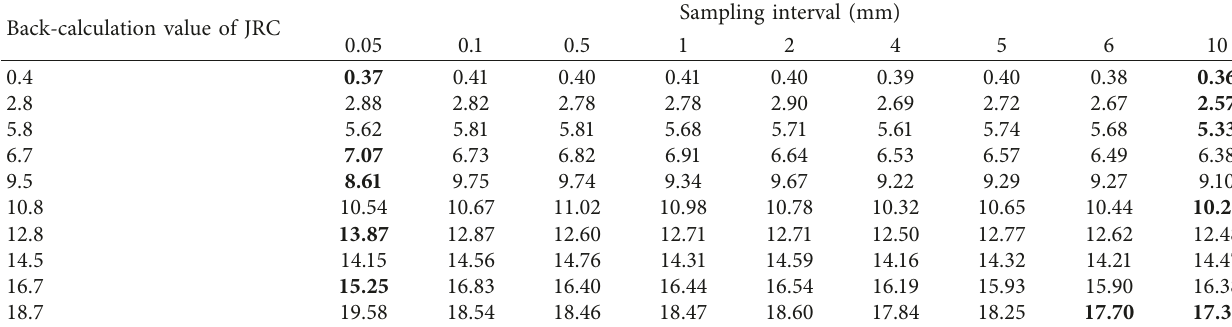
Figure 7: Calculated value of the JRC ( Δ x � 0.5 mm). Table 3: Calculated JRC values at different Δ x